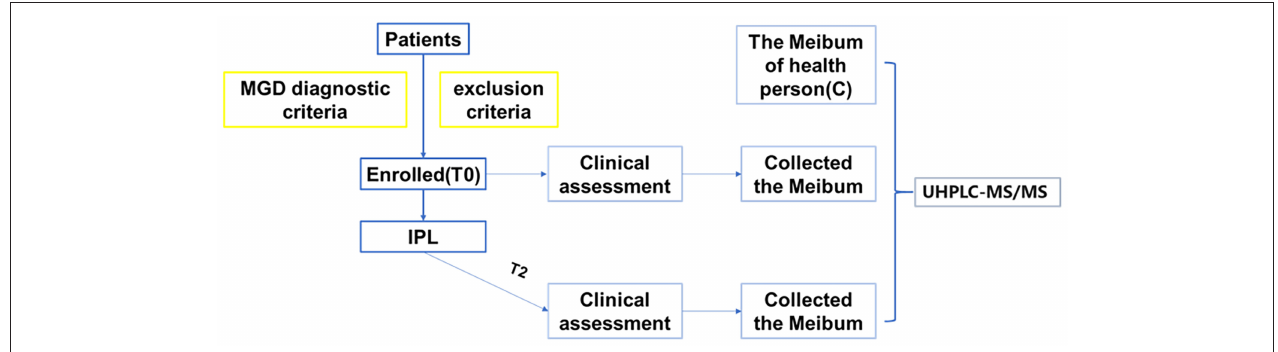
FIGURE 1 | A working diagram of data